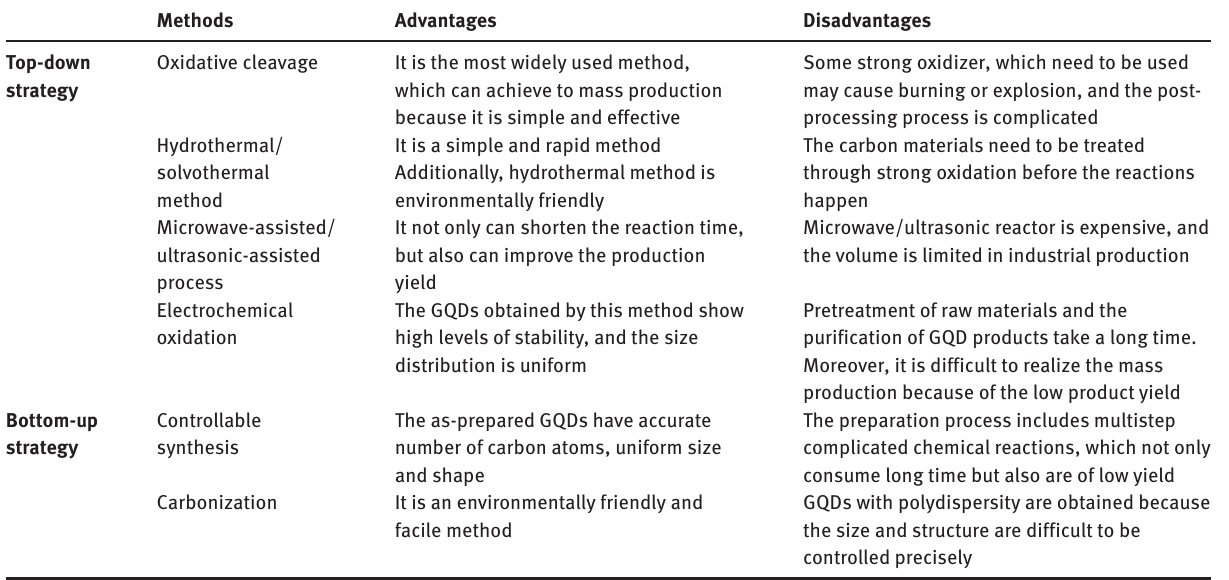
Table 1: The respective advantages and disadvantages of different methods.